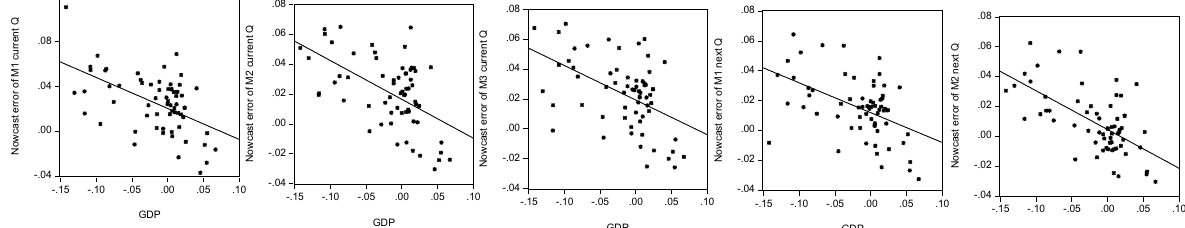
Fig. 3 Scatterplots between y–o-y GDP growth and the y–o-y nowcasting errors of the disaggregated Midas